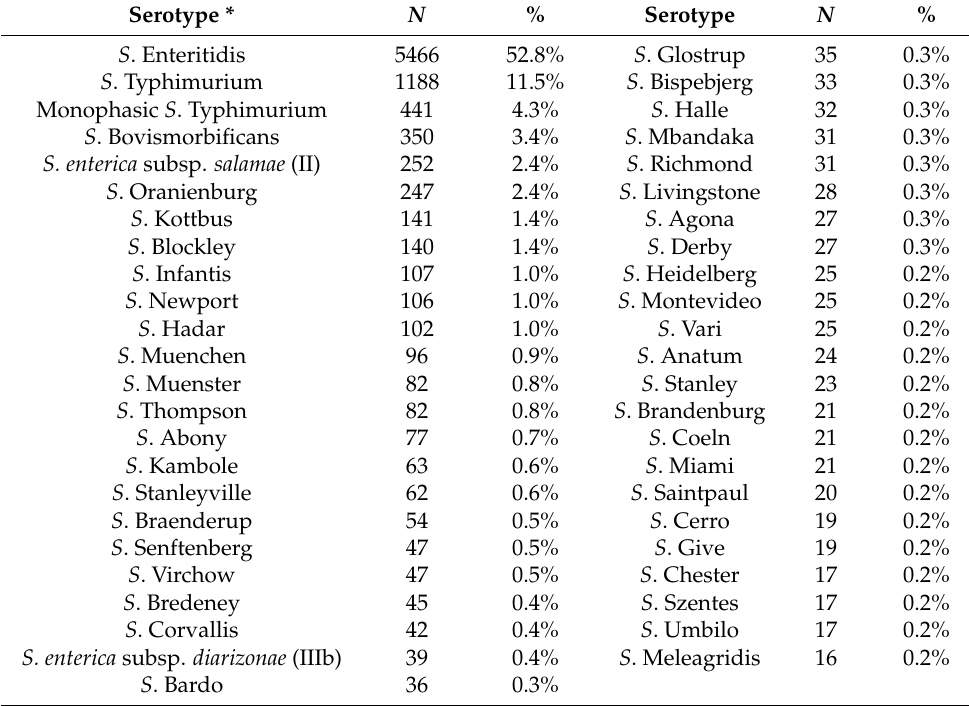
Table 1. The number ( N ) of isolates and proportion (%) of the most frequently identified serotypes, Greece, 2003–2020.